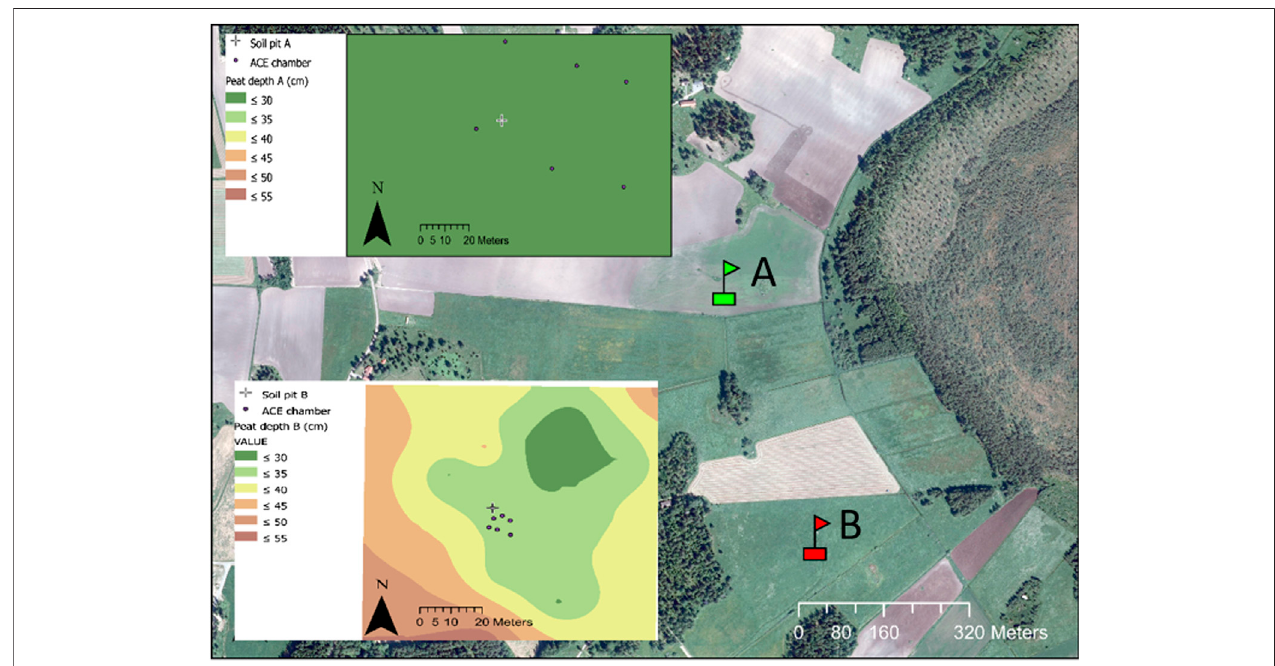
FIGURE1| Mapshowingthelocationofthecultivatedpeatlandsite(soilpitA,green fl ag)andtheset-asidesite(soilpitB,red fl ag)and(inserts)showingpeatdepth and the positions of the soil pits and automatic chambers (ACE) at each site.